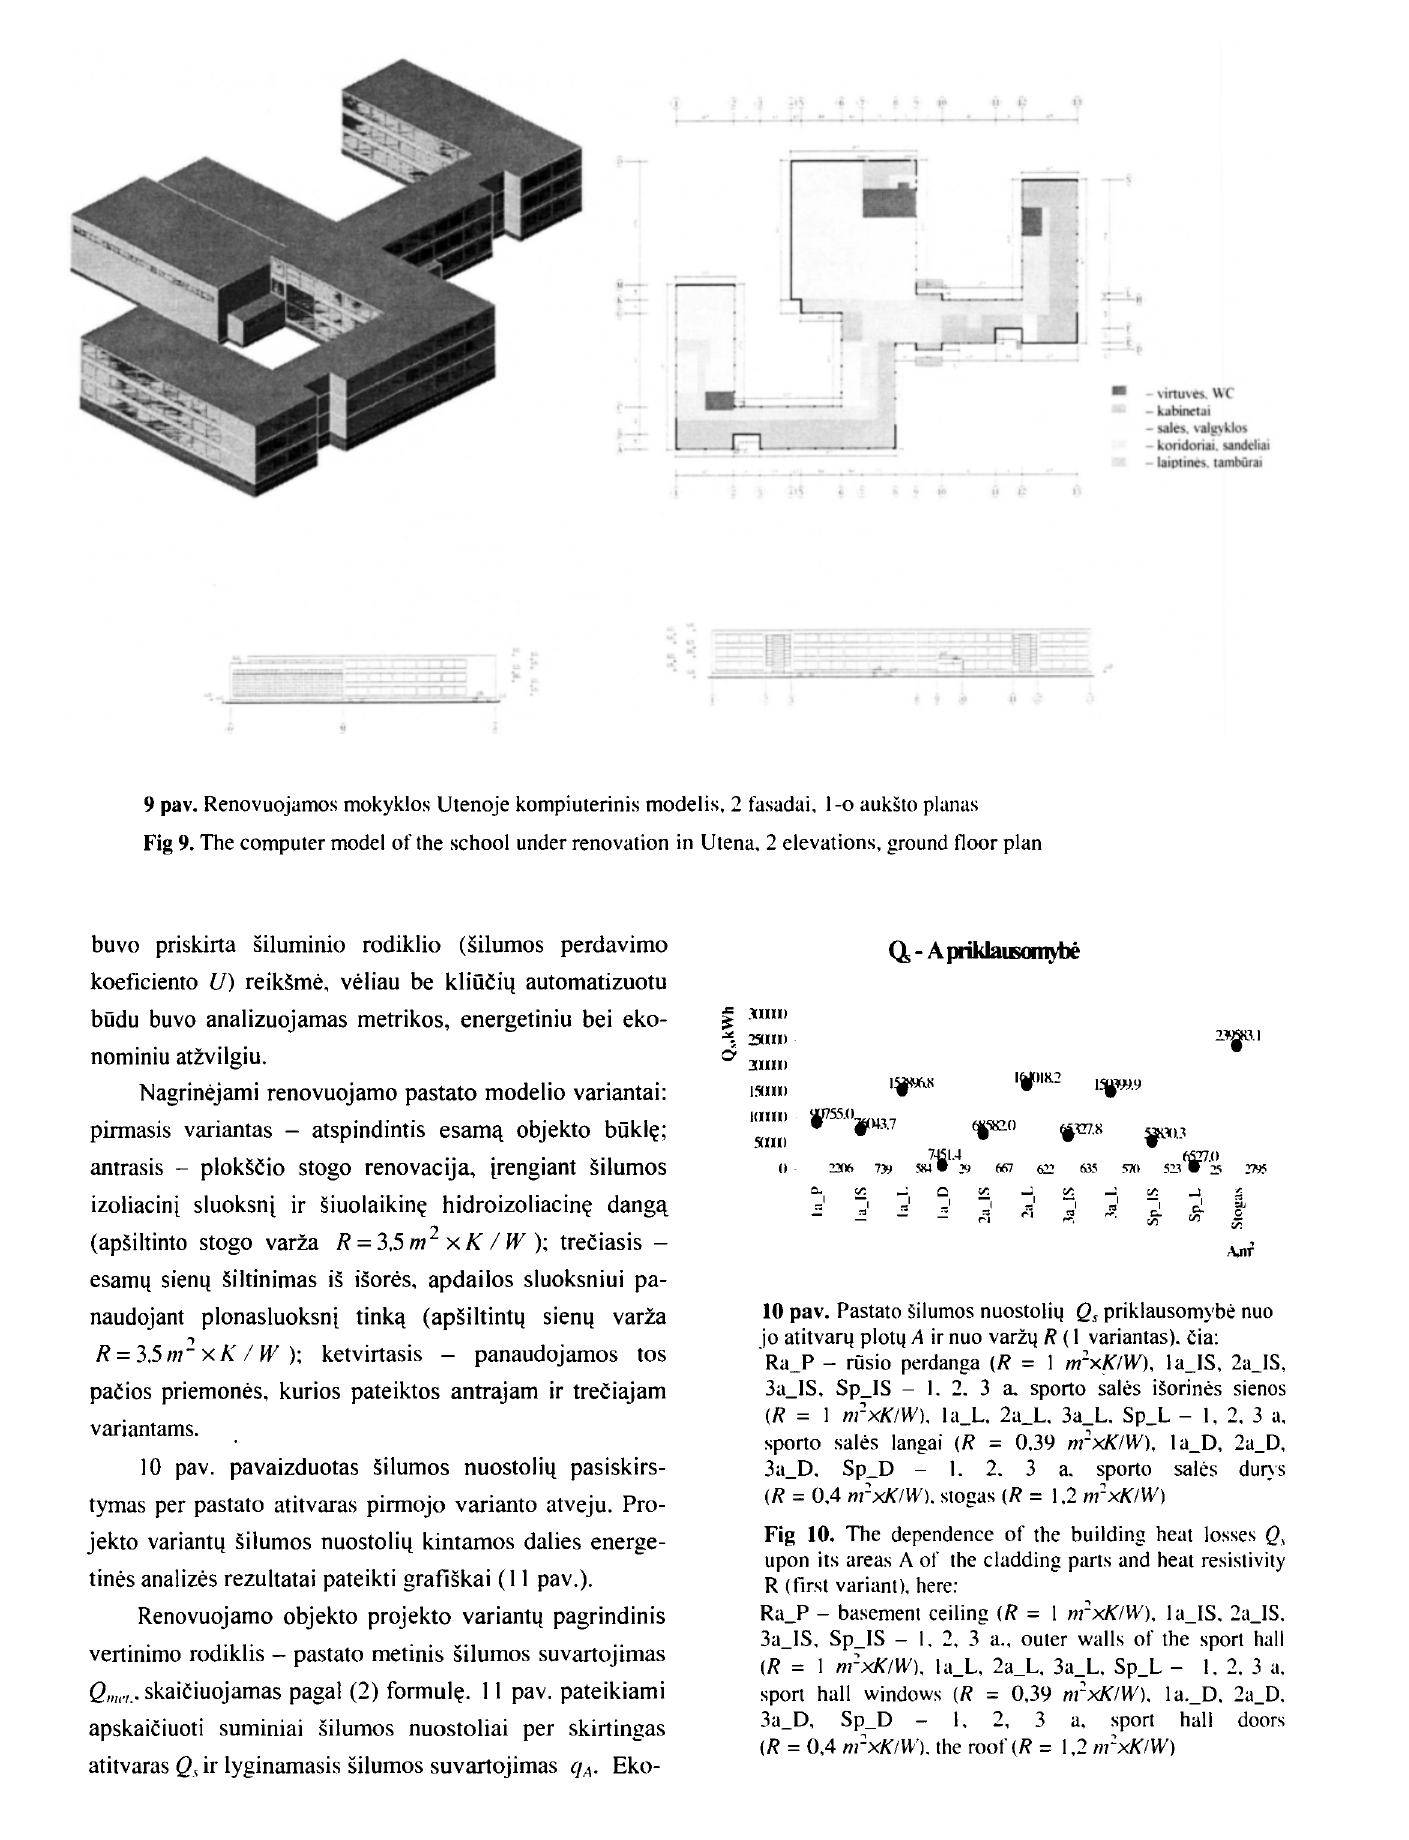
Fig 10. The dependence of the building heat losses Q, upon its areas A of the cladding parts and heat resistivity R (tirst variant),